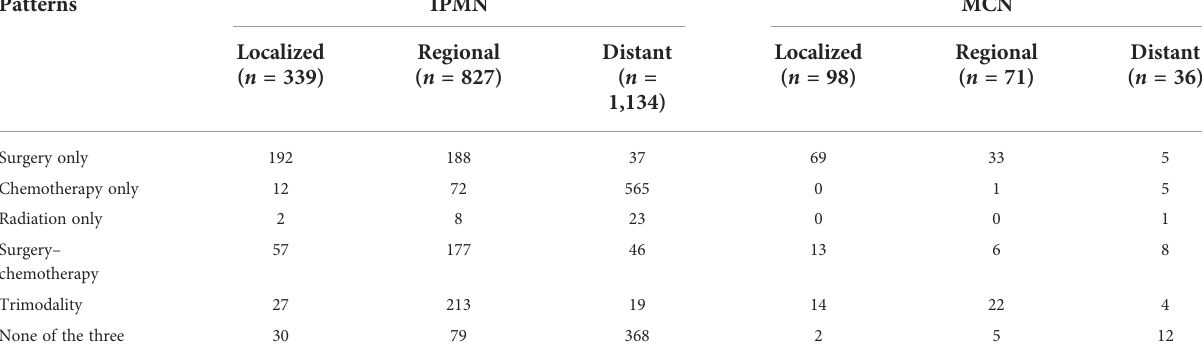
TABLE 4 Treatment patterns of IPMN and MCN patients in different stages. Patterns